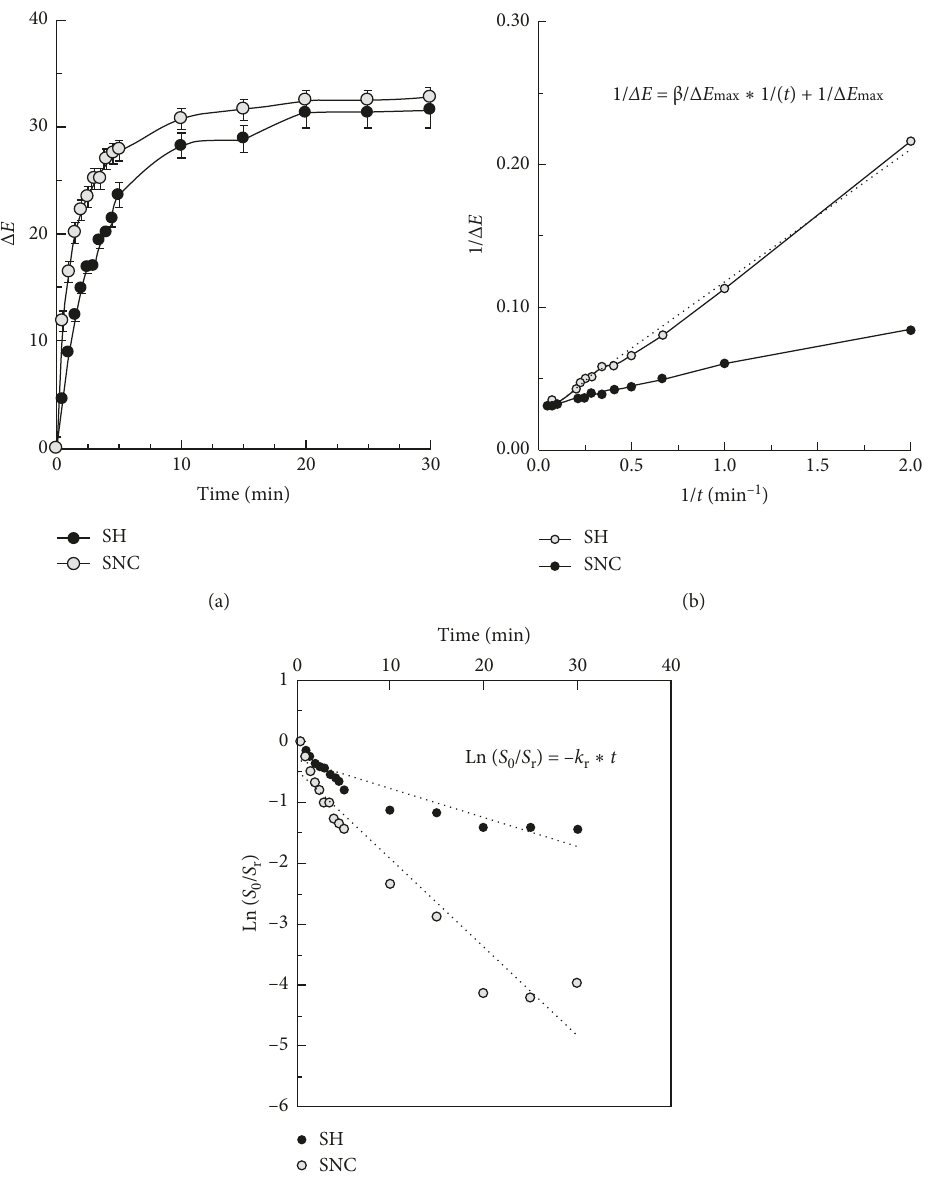
Figure 1: Evolution of the color change given by Δ E (a), the linearized Michaelis–Menten-type curves (b), and the adjustment to first-order kinetics for enzymatic browning (c) of SH and